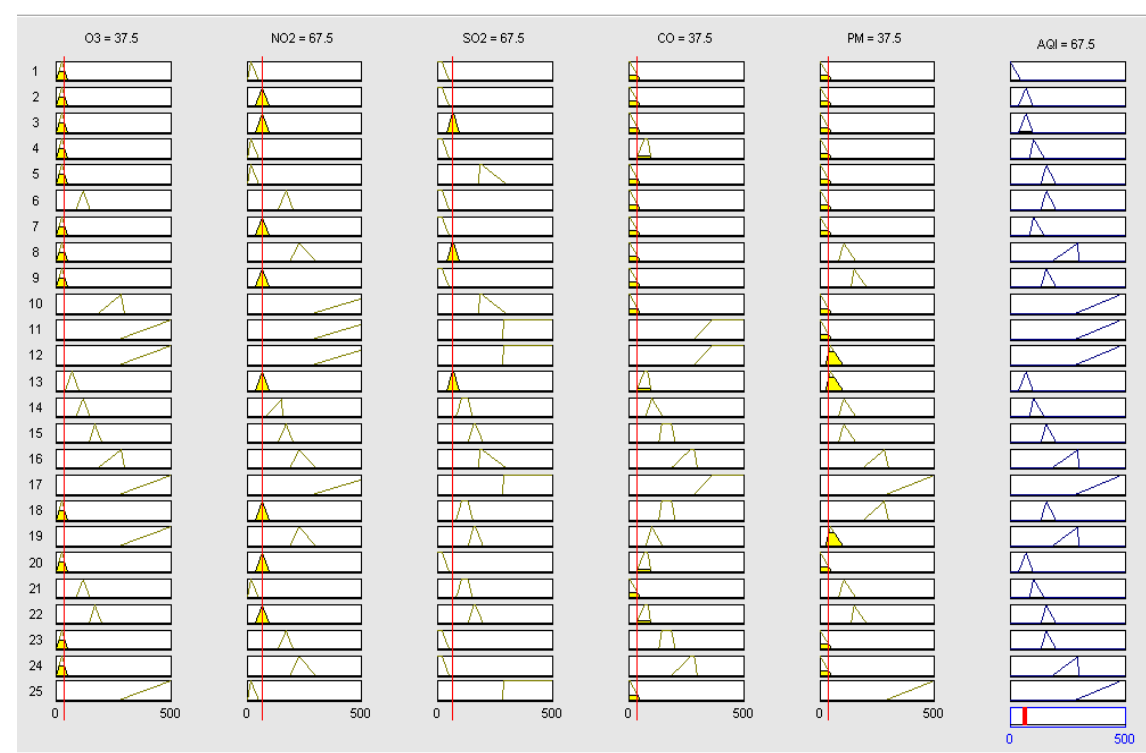
Fig. 8. The rules of fuzzy